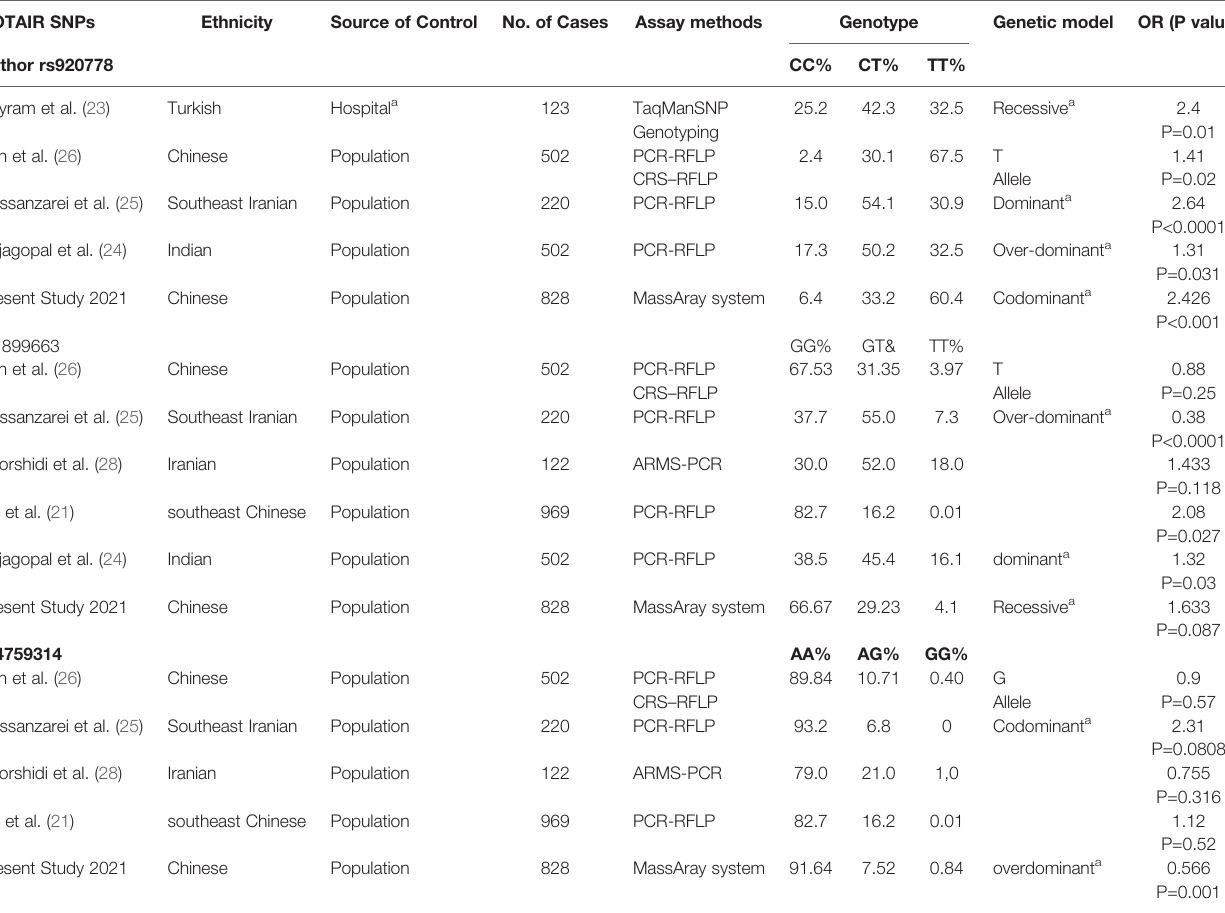
TABLE 9 | Comparison of previous studies with our study in the association of HOTAIR SNPs and BC risk. HOTAIR SNPs Ethnicity Source of Control No. of Cases Assay methods Genotype Genetic model OR (P